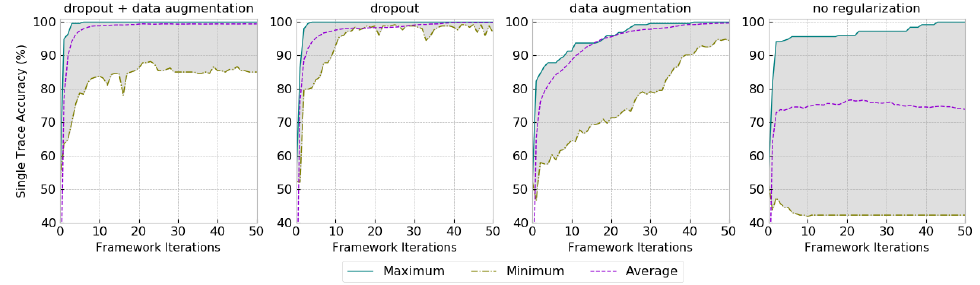
Figure 14: Random CNN hyperparameters: minimum, maximum, and average single trace accuracy with iterative framework on cswap-arith dataset and attacking the sample interval range from 1 500 to 3 500 of all